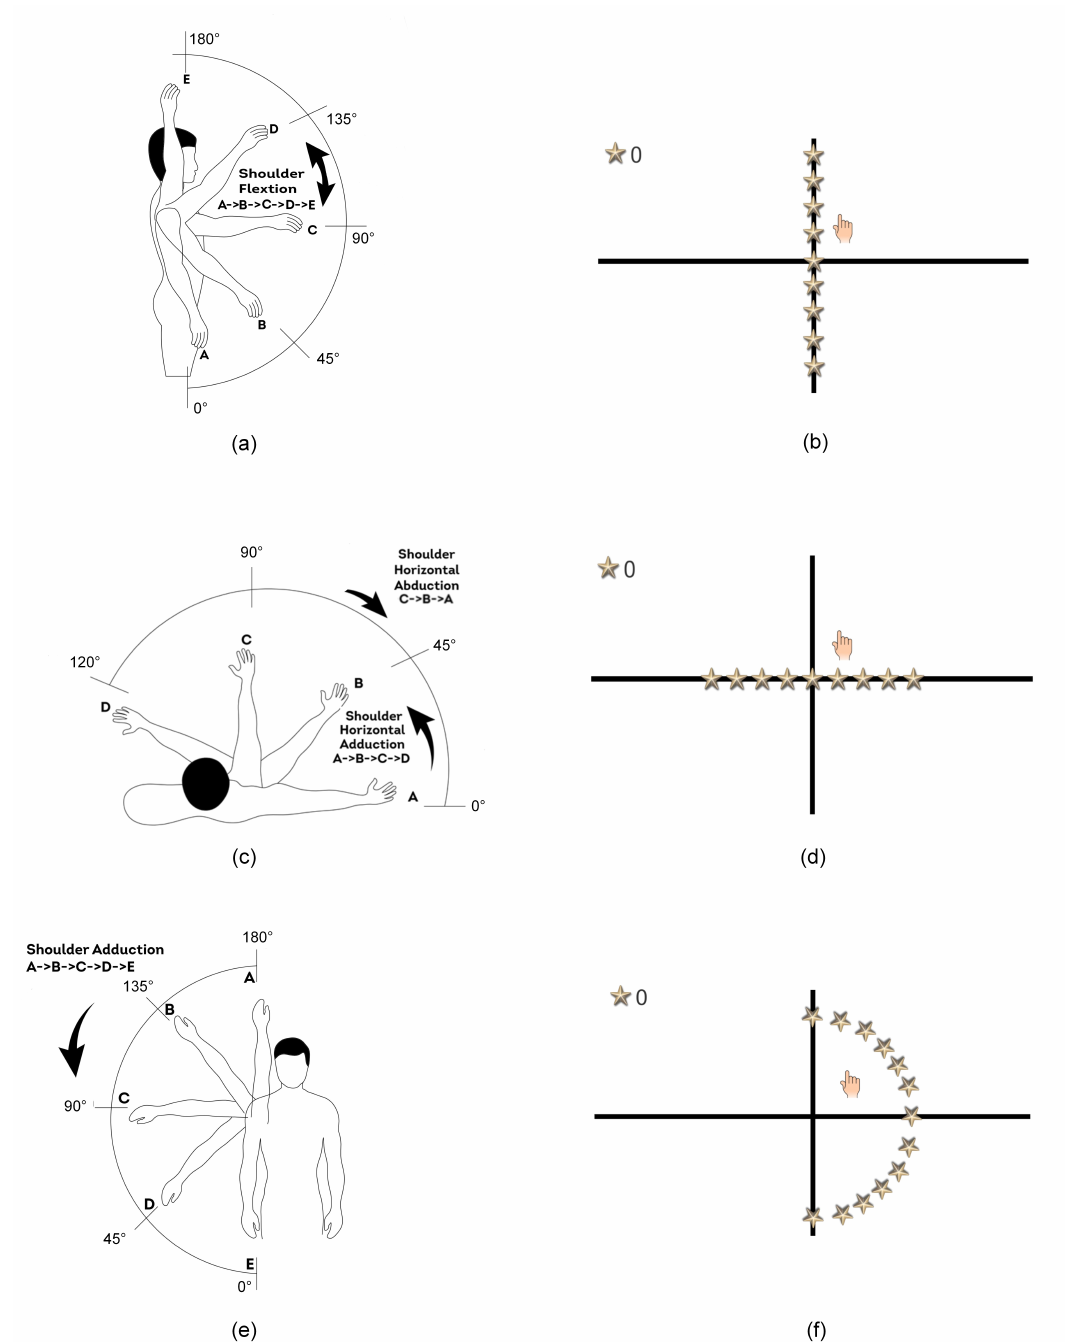
Figure 3. ( a , b ): ( a ) The shoulder flexion physical exercise and ( b ) the corresponding shoulder flexion game-based exercise. ( c , d ): ( c ) The shoulder horizontal abduction physical exercise followed by the shoulder horizontal adduction physical exercise and ( d ) the corresponding shoulder horizontal abduction/adduction game-based exercise. ( e , f ): ( e ) The shoulder adduction physical exercise and ( f ) the corresponding shoulder adduction game-based